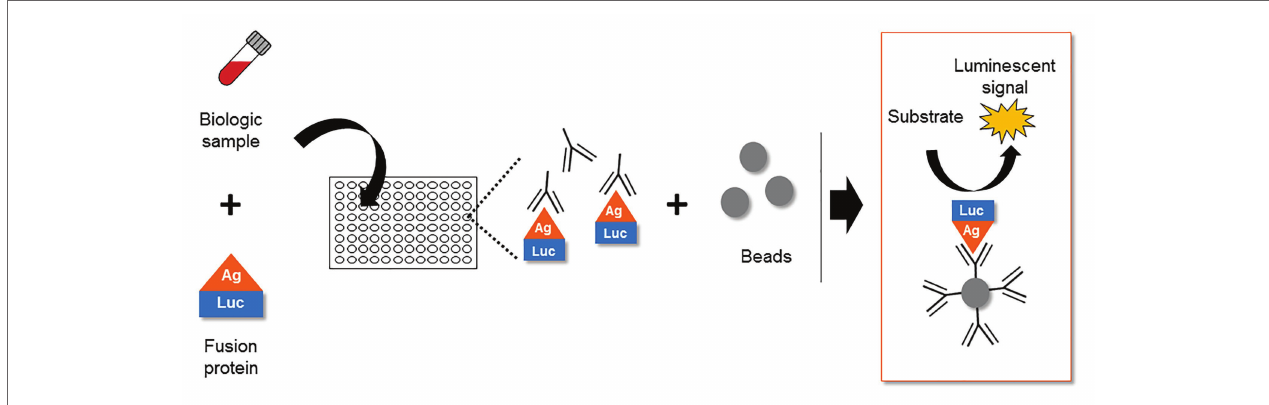
FIGURE 5 | The Luciferase Immuno-Precipitation System (LIPS) as a detection assay to measure antigen-specific antibodies in biological samples of infected patients. The biological samples (plasma, serum, lactoserum, etc.) potentially containing antigen-specific antibodies are incubated with a fusion protein between the antigen and a luciferase. After an immuno-precipitation step, the substrate of the luciferase is added. The detection of a luminescent signal indicates the presence of antigen-specific antibodies in the biological